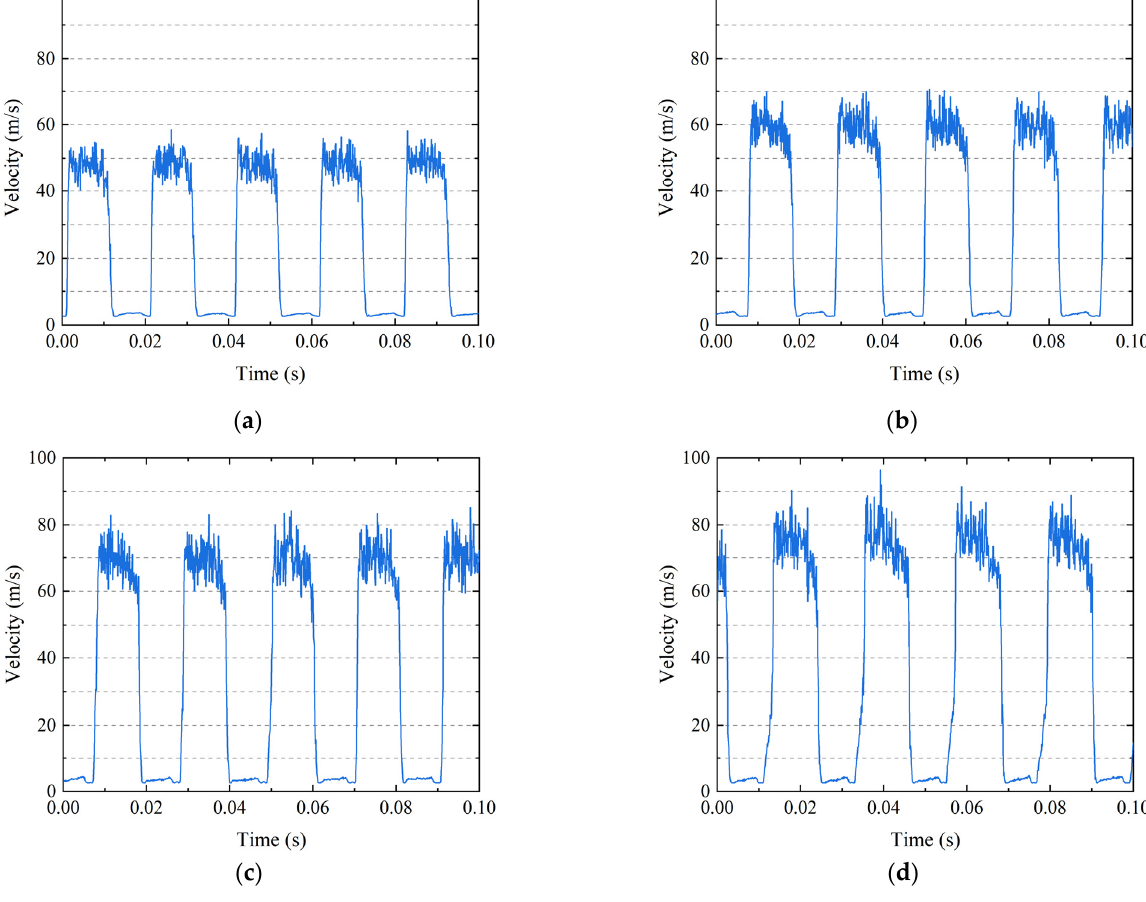
Figure 10. The oscillator velocity response at: ( a ) 𝑃 (cid:3036) /𝑃 (cid:3028)(cid:3047)(cid:3040) = 1.3; ( b ) 𝑃 (cid:3036) /𝑃 (cid:3028)(cid:3047)(cid:3040) = 1.5; ( c ) 𝑃 (cid:3036) /𝑃 (cid:3028)(cid:3047)(cid:3040) = 1.7; and ( d ) 𝑃 (cid:3036) /𝑃 (cid:3028)(cid:3047)(cid:3040) = 1.9.